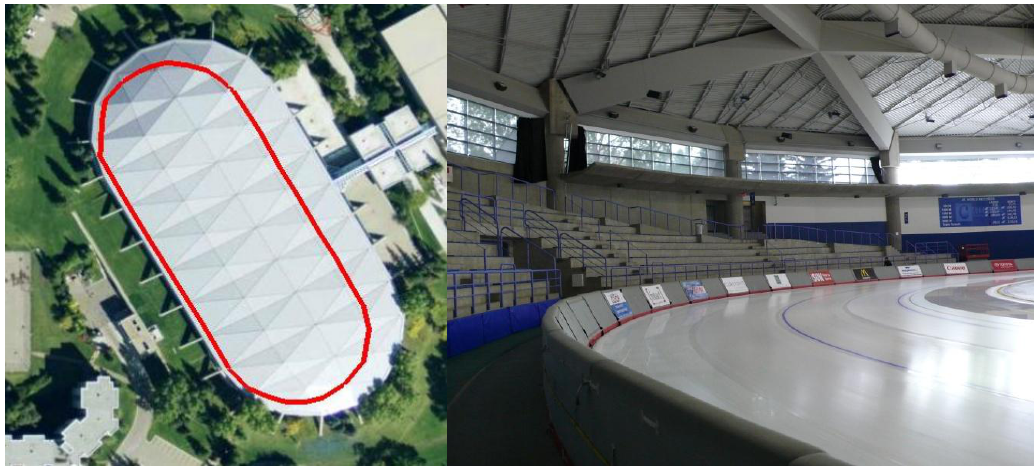
Figure 5. Olympic Oval (Left: roof top with trajectory in red, Right: inside showing track and ice